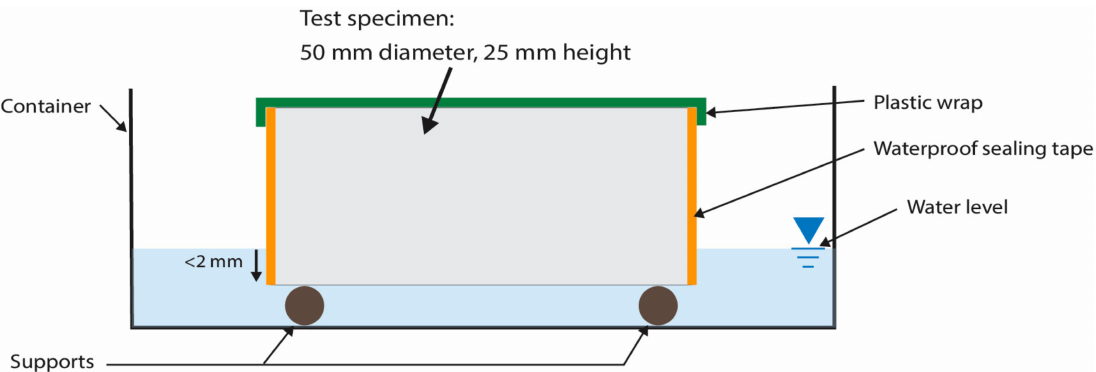
Figure 2. Schematic of the experimental setup for sorptivity testing, per the modified ASTM C1585 test